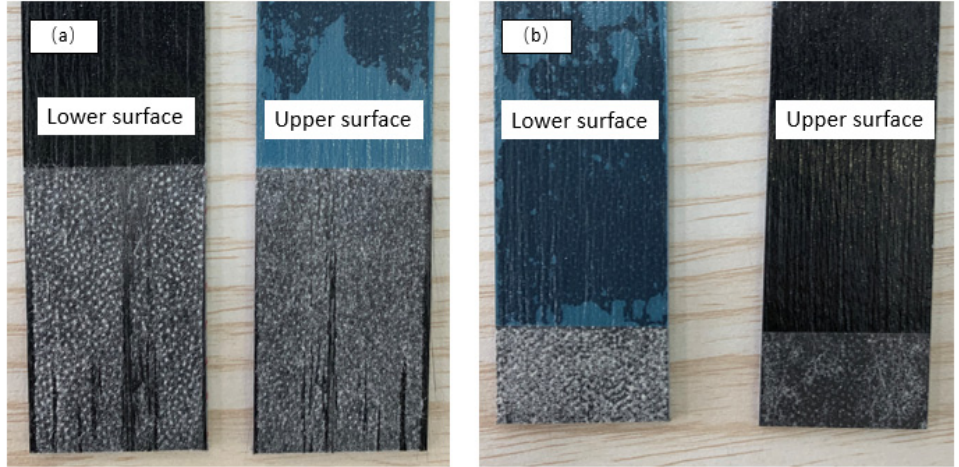
Figure 10. Plane view of fracture surfaces of NVIC -ILT . ( a ) Mode I, ( b ) Mode II.